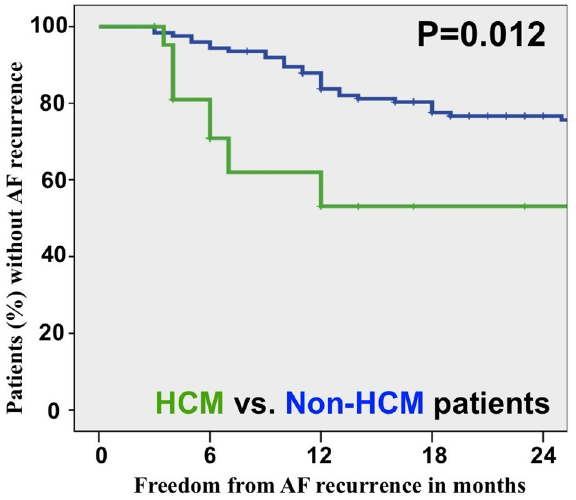
Figure 3. Kaplan–Meier curve depicts the time to first recurrence after last ablation. AF, atrial fibrillation; HCM, hypertrophic